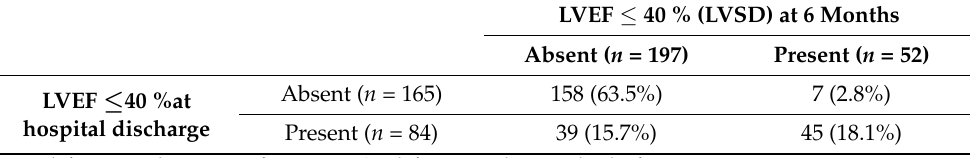
Table 3. Occurrence of LVEF ≤ 40 % on transthoracic echocardiography at hospital discharge and at 6